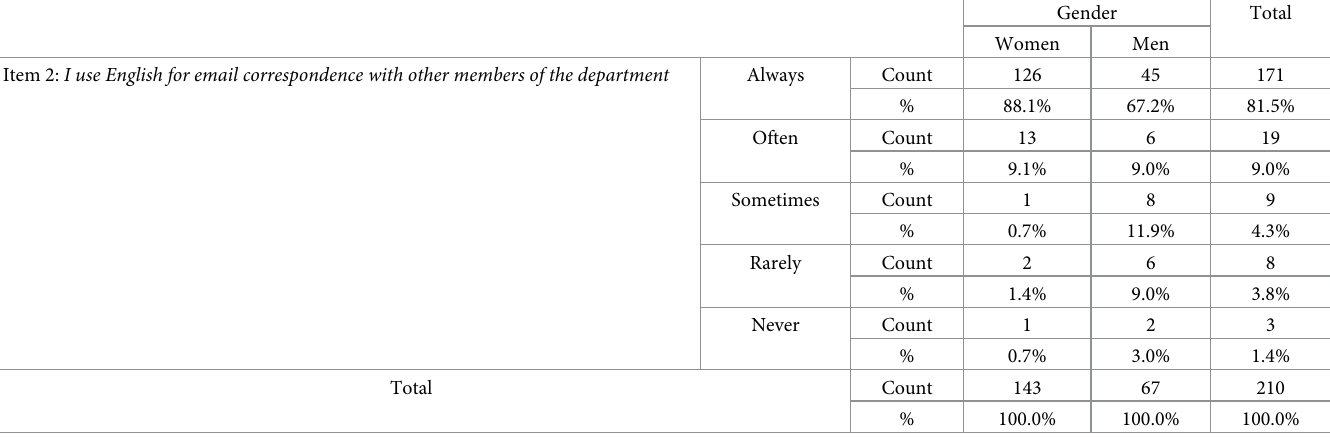
Table 3. Use of English for email